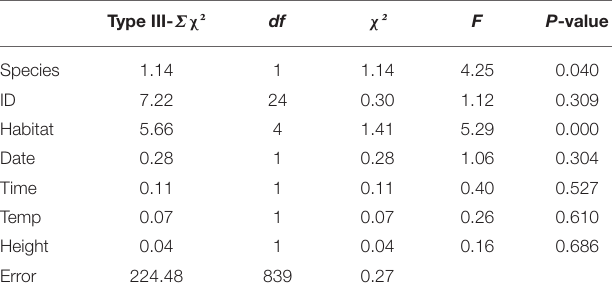
TABLE 5 | Results of the GLM to test the factors of importance between the two species during the spring tracking experiment. Type III- Σ χ ² df